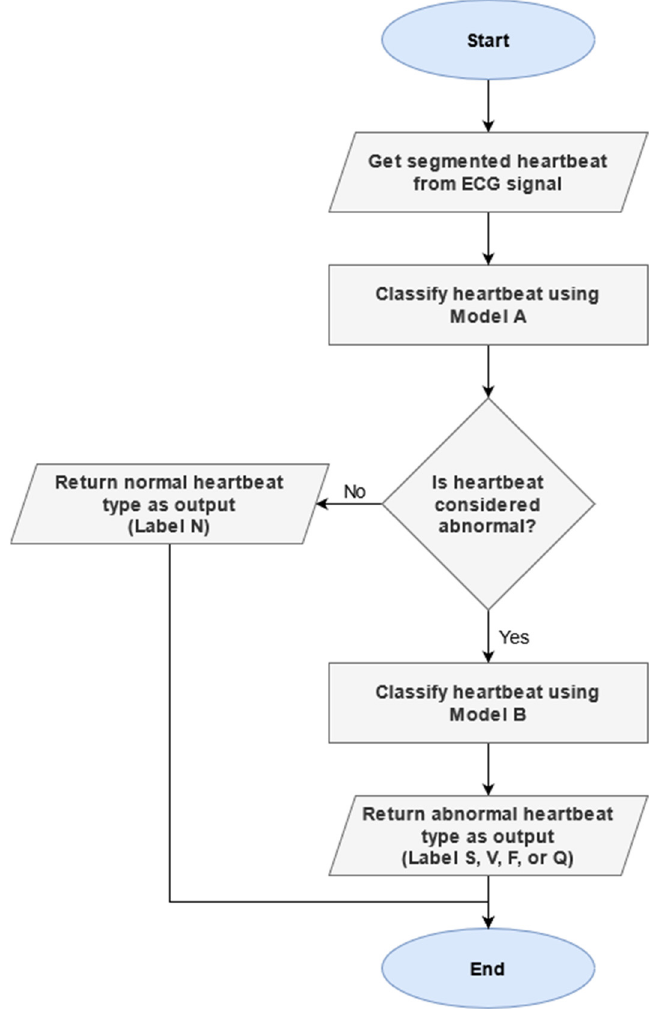
Figure 8. Flowchart of two-phase classification process.